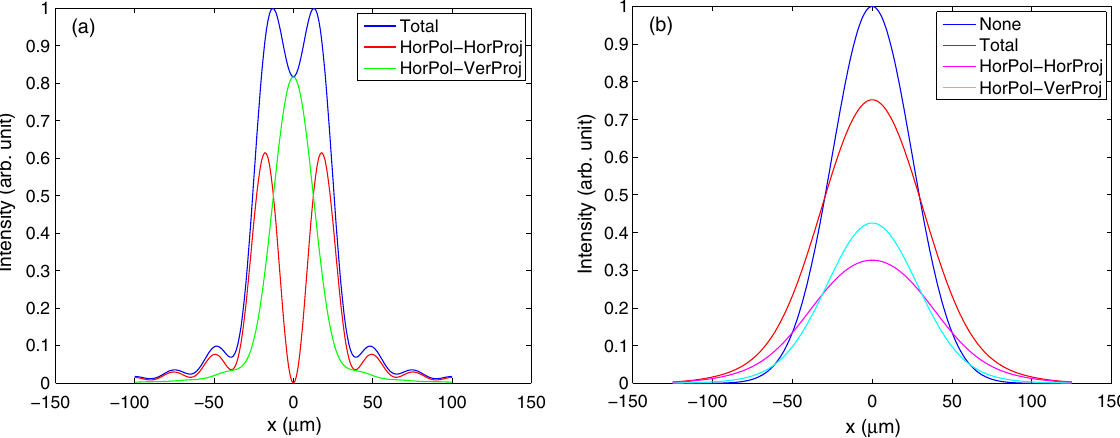
FIG. 6. (a) OTR PSF projections of the images in Fig. 5 with total, horizontal polarization with horizontal projection, and the vertical projection of the same case. (b) Comparison plots of the original x size ( 25 (cid:1) m ) with no convolution and convolutions with the OTR PSF projections of the total ( 33 : 1 (cid:1) m ), horizontal polarization-horizontal projection ( 37 : 7 (cid:1) m ), and the vertical projection ( 29 : 3 (cid:1) m ) of the same latter